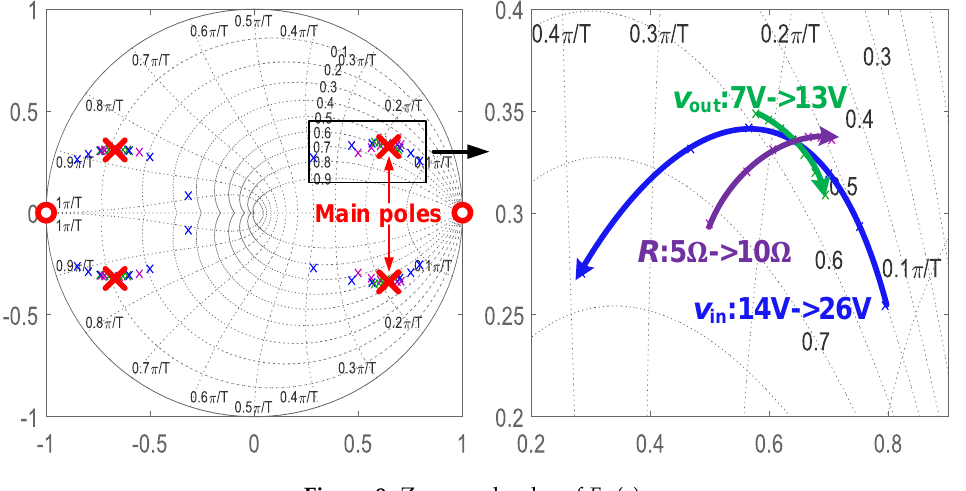
Figure 9. Zeros and poles of F vl ( z ).